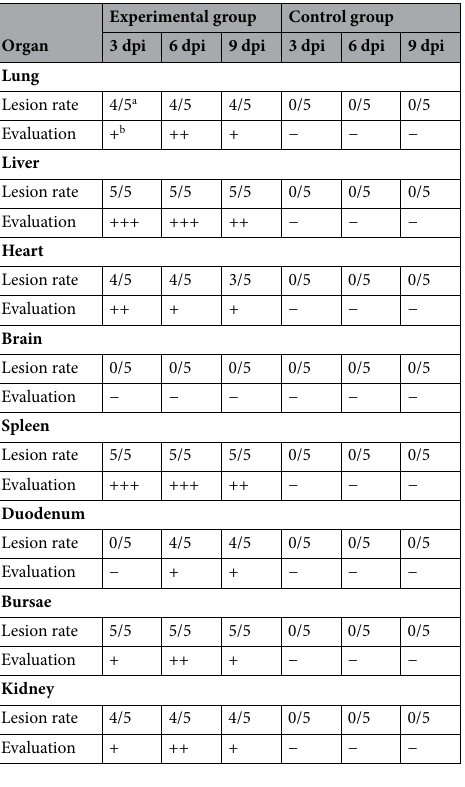
Table 2. Microscopic lesions in infected chickens of two different groups at 3 dpi and 6dpi. a Number of chickens exhibiting microscopic lesions in the sacrificed chickens infected with NDRV. b Severity of microscopic lessions: − , no microscopic lesions; +, mild microscopic lesions; ++, moderate microscopic lesions; +++, severe histological